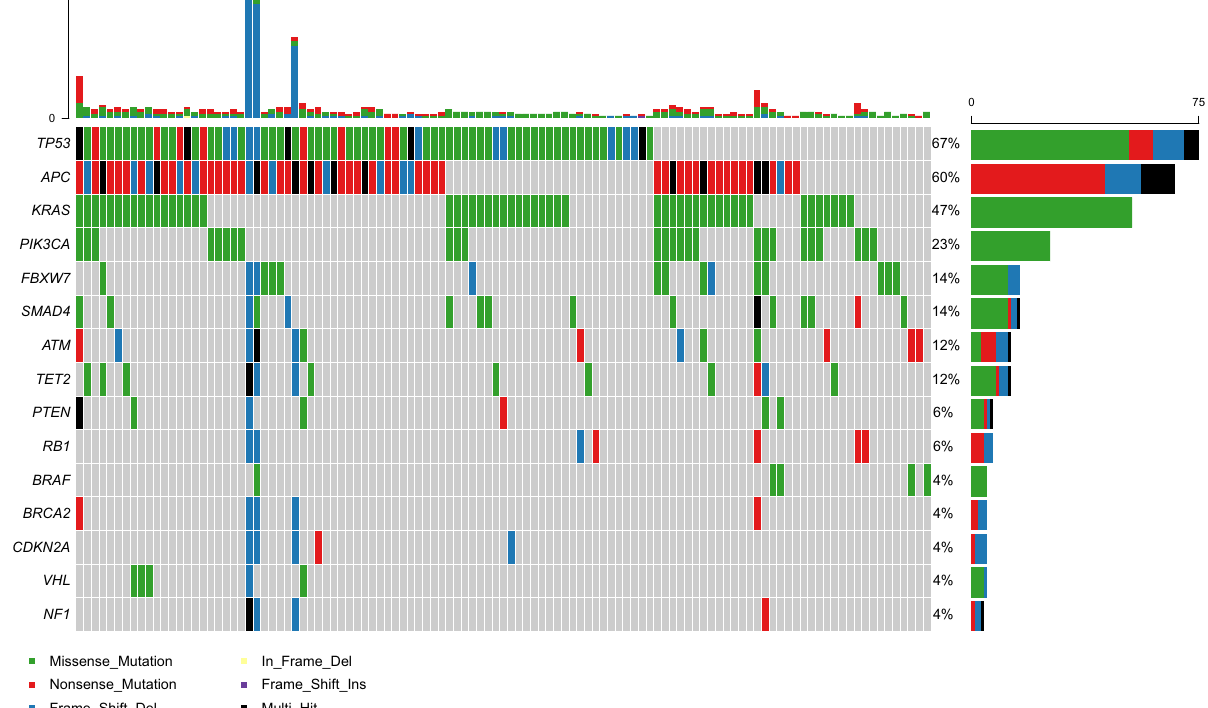
Figure 1. Oncoplot of the top 15 most frequently mutated genes in 115 cases. This shows the list of top 15 genes arranged based on the total number of variants in each gene, and the percentage following each gene represents the ratio of tumor samples with its genetic alteration to the total samples. Colored squares indicate the mutated genes, while gray squares indicate the non-mutated genes. Note 1: The oncoplot was depicted with 115 cases which are available for the genetic alterations of APC. Note 2: Variants annotated as Multi_Hit refer to those genes that mutated more than once in the same